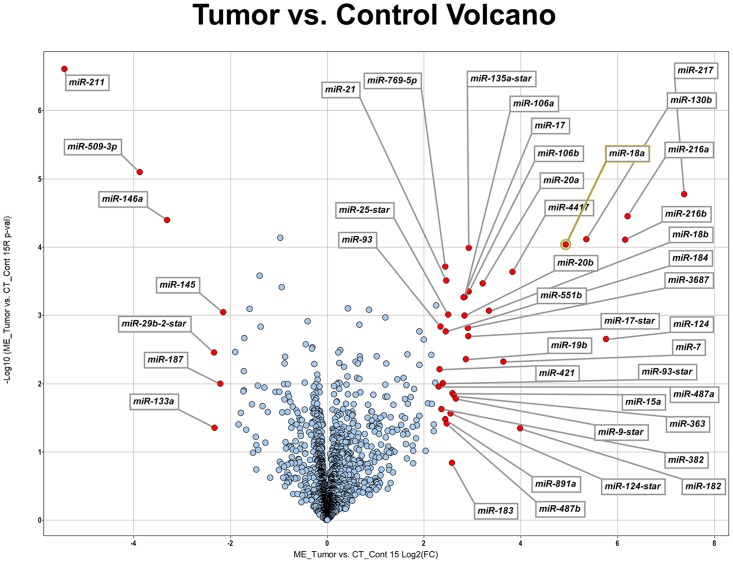
Volcano plot of differentially expressed miRNAs in seven cases of medulloepithelioma.The x-axis shows the log2 fold-change in miRNA expression and y-axis shows the-Log10 of the p-value from tumor versus control miRNA expression counts. Labelled miRNAs have Log2 fold change greater than 2SD from the mean.